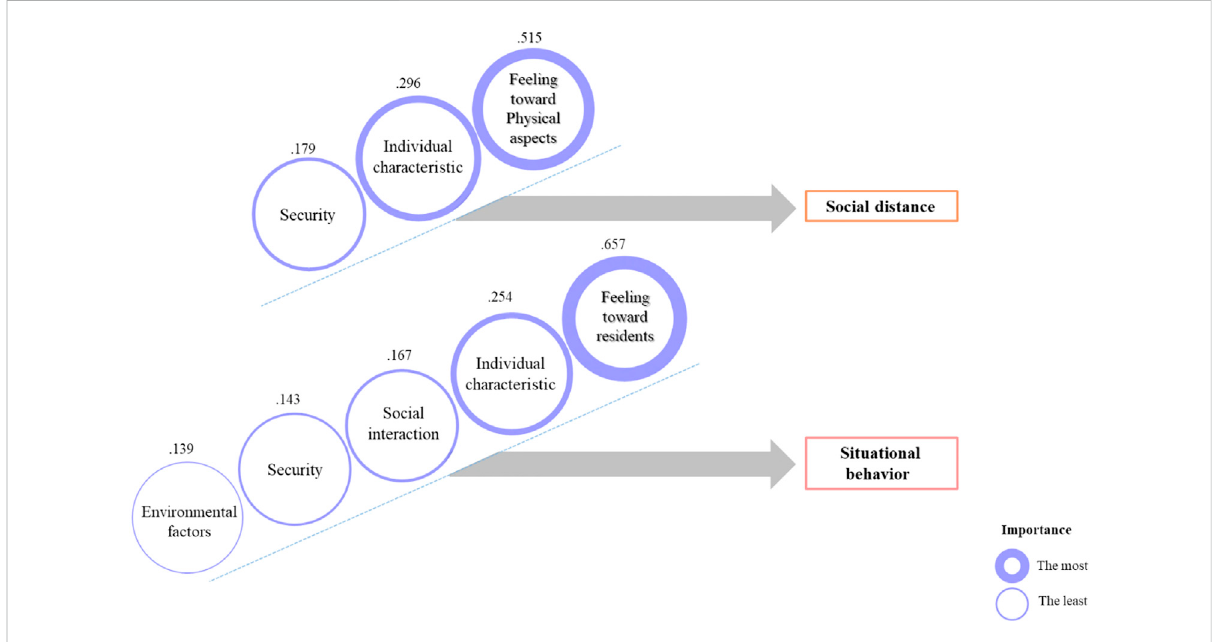
FIGURE 1 Effects of cognitive and affective factors on behavioral